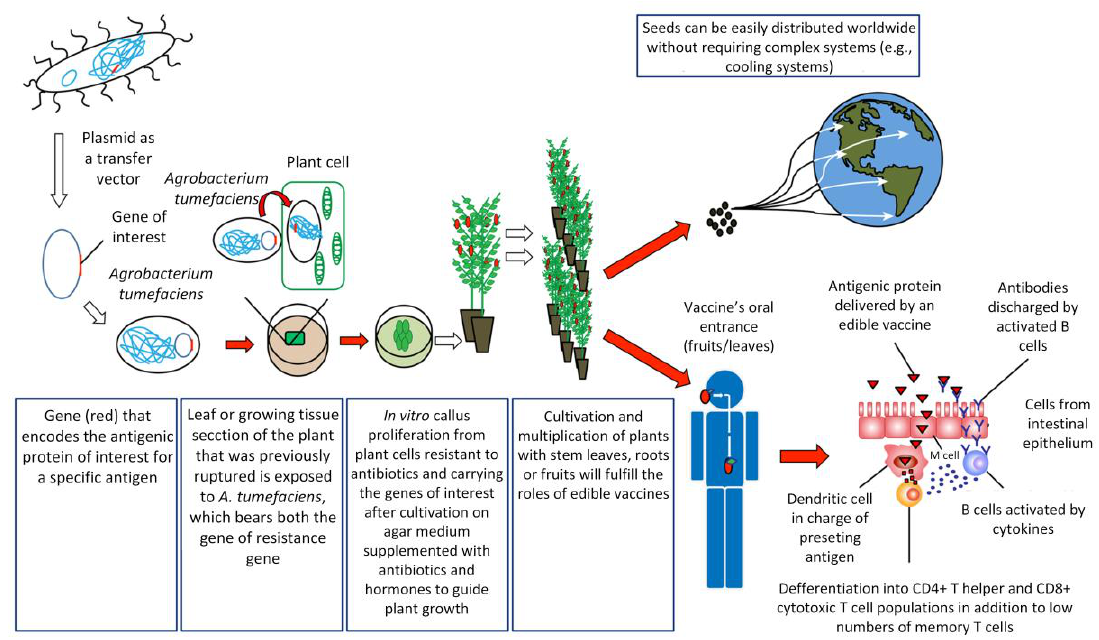
Figure 1. Procedures involved in obtaining an edible vaccine and an immune response. Edible vaccine development begins with the identification of the gene encoding the antigenic protein and its introduction into the plant that will process the food (edible vaccines), which can then potentially be distributed globally. After an edible vaccine has been consumed, and the subsequent passage of the antigenic protein through the M cells specialized in the delivery of antigens to dendritic cells, the individual’s immune system triggers a response involving B cells and T helper cells as the main factors. For simplicity, other routes of antigen delivery have been omitted. This figure was adapted from the work of Langridge [4].